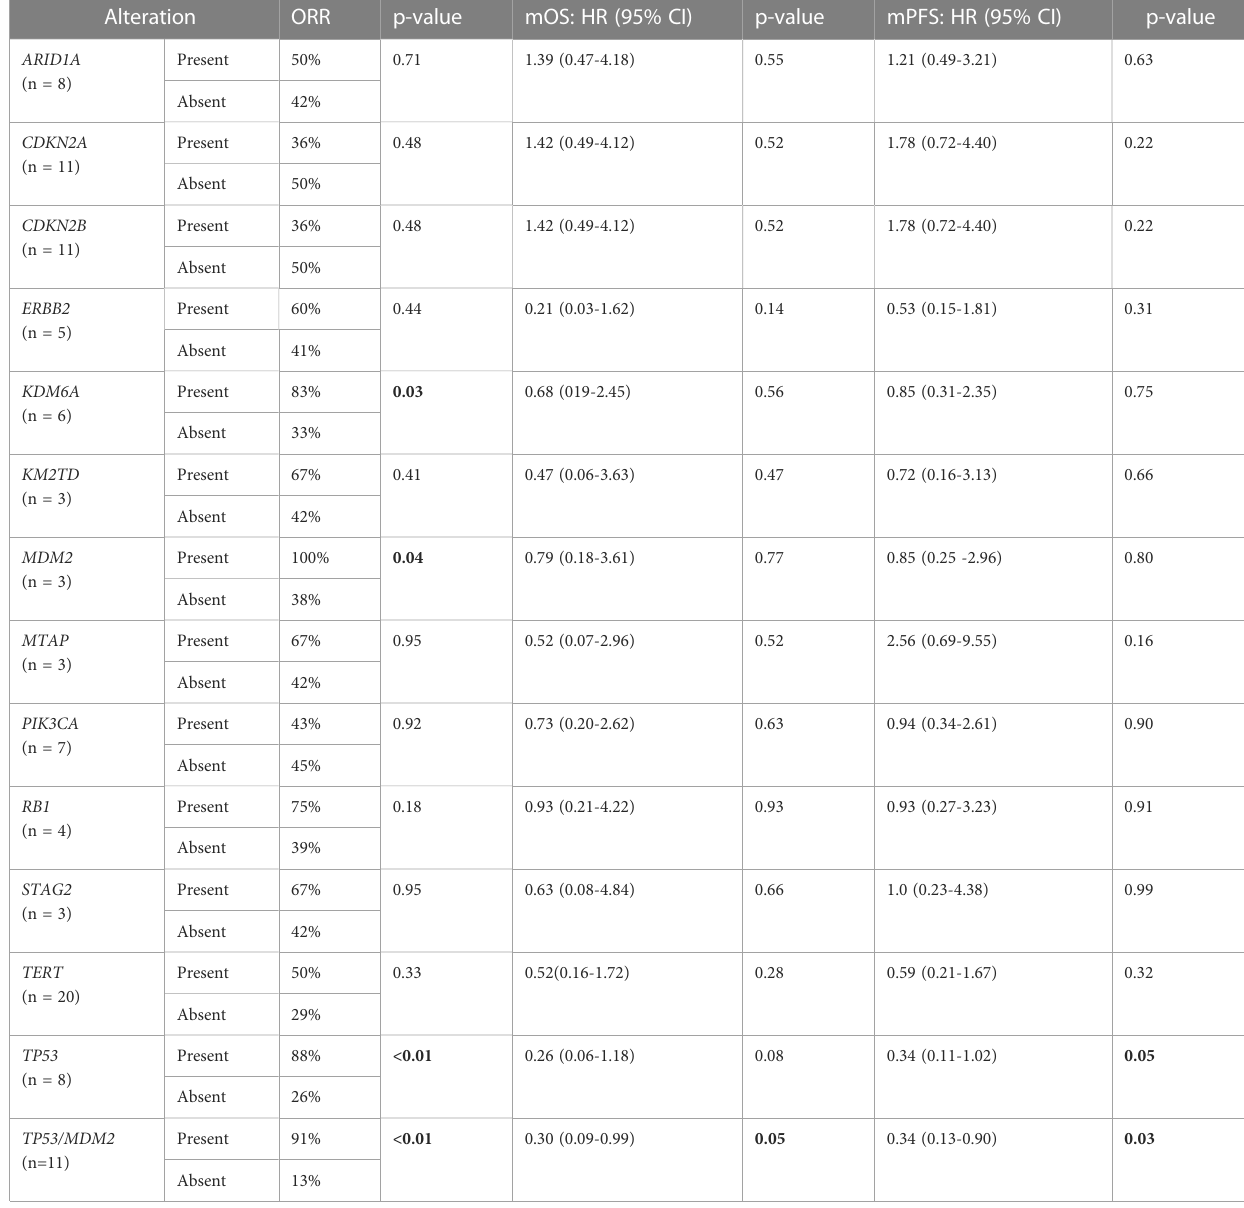
TABLE 2 Genomic Characteristics - Univariable analysis of observed response, progression-free survival, and overall survival.